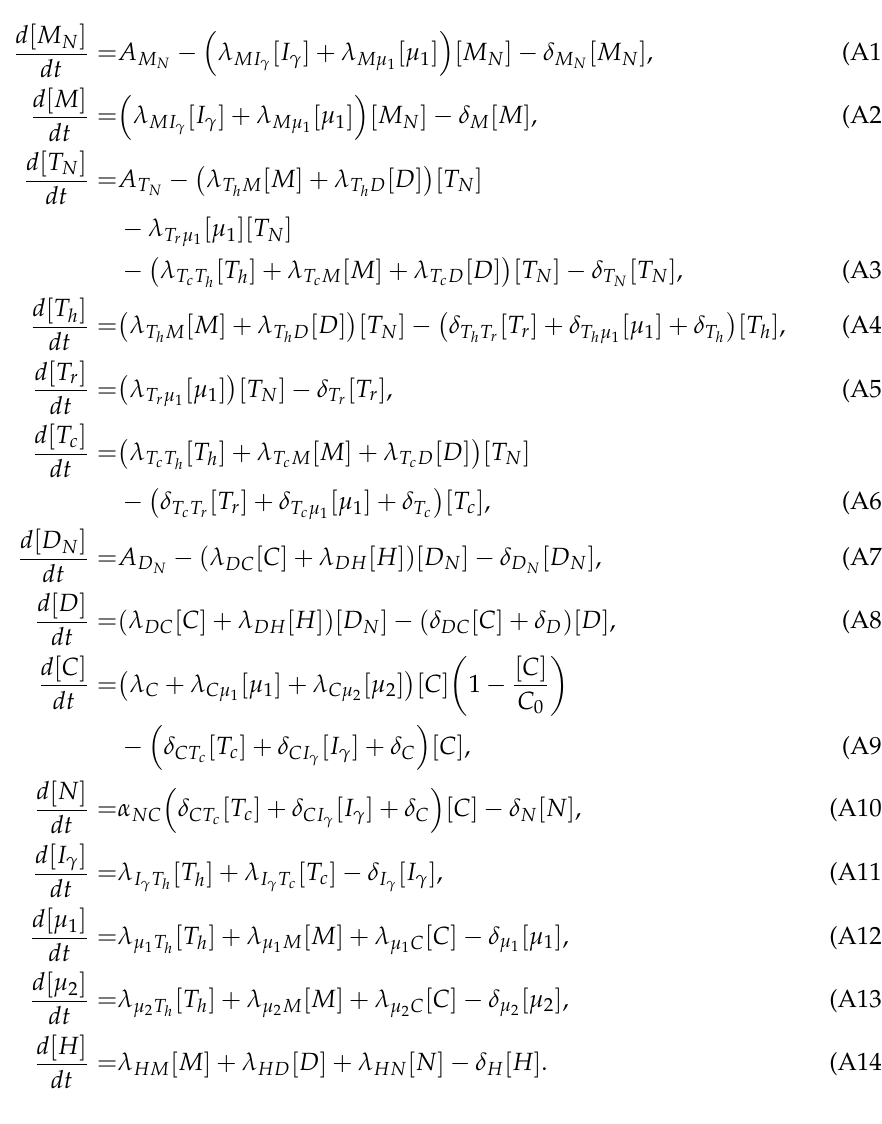
Table A1. Non-dimensional initial conditions for each